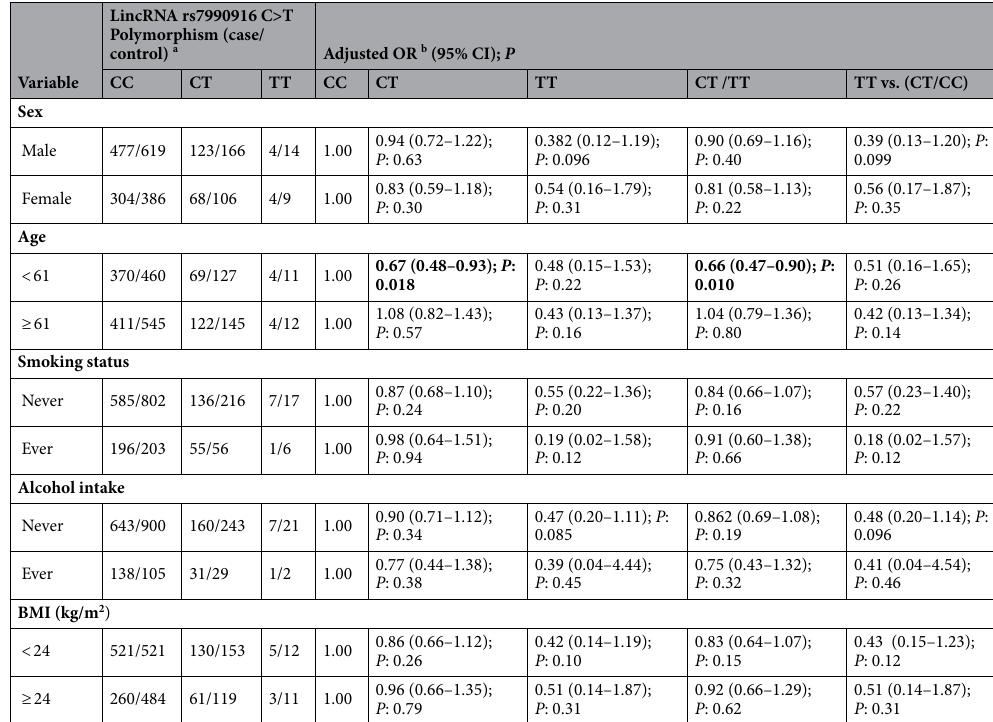
Table 5. Stratified analyses between LincRNA rs7990916 C>T Polymorphism and CRC risk by gender, age, BMI, smoking status and alcohol intake. a For LincRNA rs7990916 C>T, the genotyping was successful in 977 (97.41%) CRC cases, and 1298 (99.62%) controls; b Adjusted for multiple comparisons [age, sex, BMI, smoking status and alcohol intake (besides stratified factors accordingly)] in a logistic regression model. Significant values are in [bold].